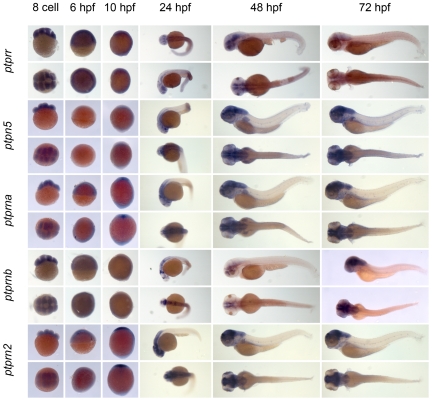
See legend to Fig. 3.